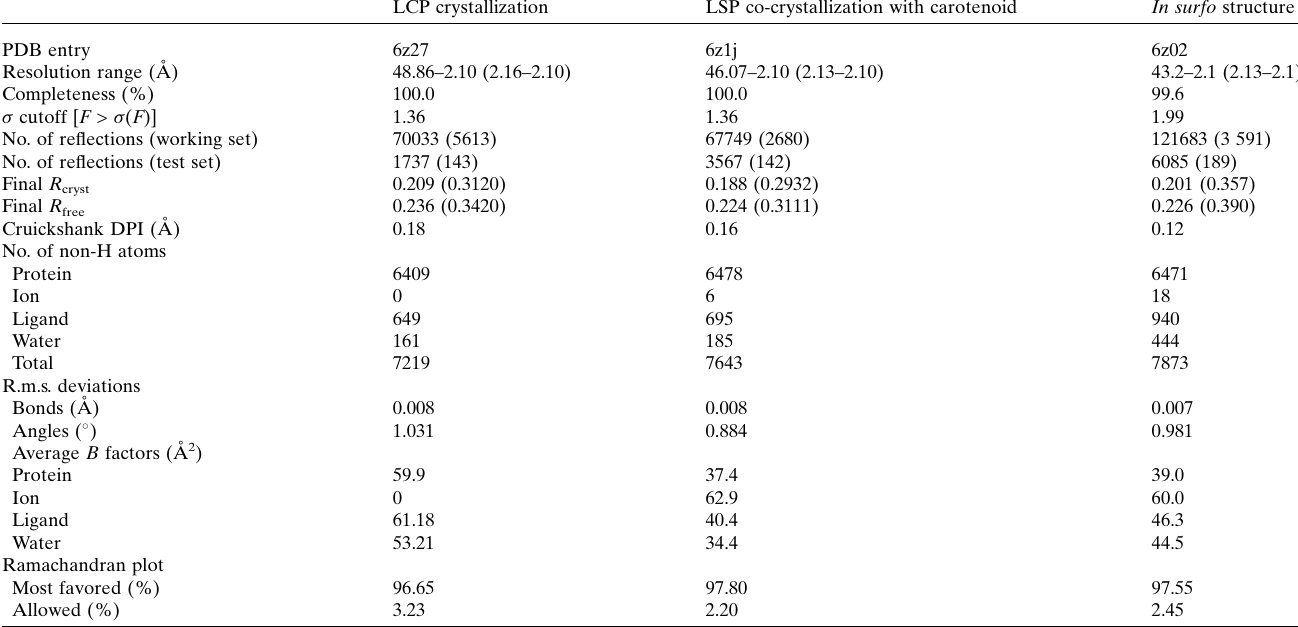
Table 2 Structure solution and refinement. LCP crystallization LSP co-crystallization with carotenoid In surfo